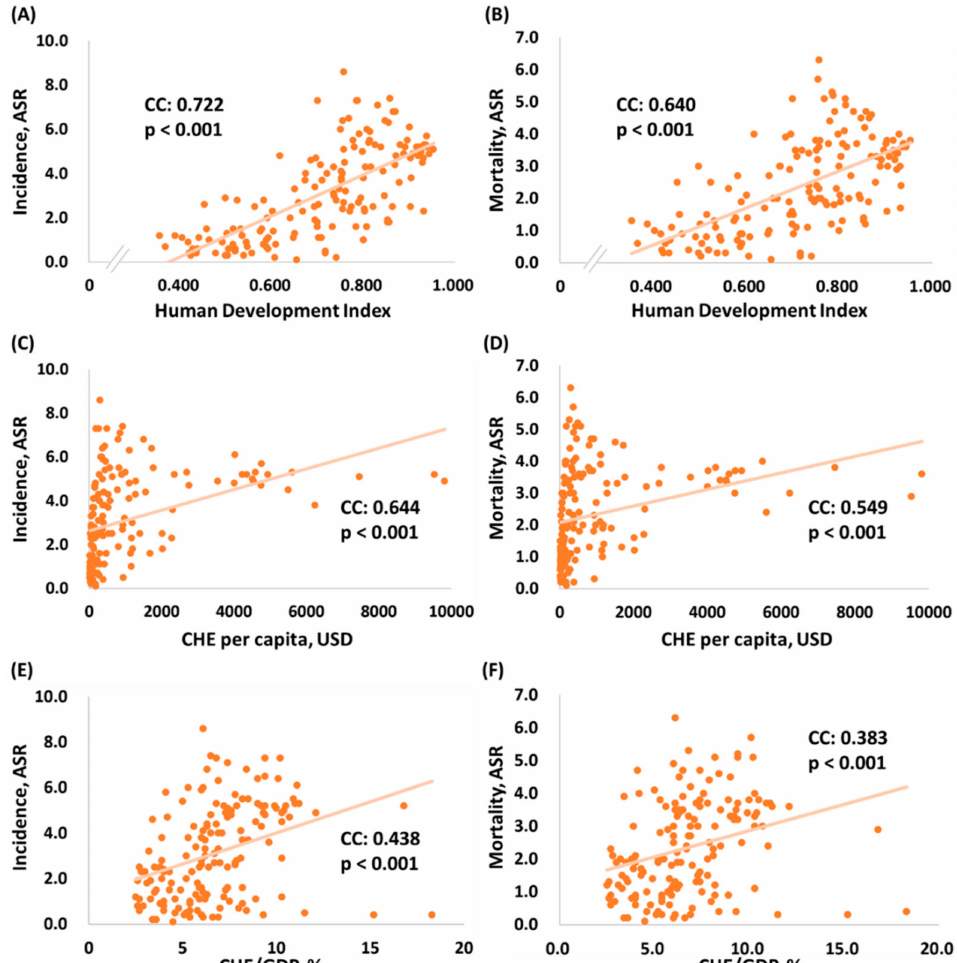
Figure 1. Association among human development index, current health expenditure and age-standardized rate of ( A , C , E ) incidence and ( B , D , F ) mortality in brain and nervous system cancers (N = 157). CHE: current health expenditure; CHE / GDP: current health expenditure as percentage of gross domestic product; ASR: age-standardized